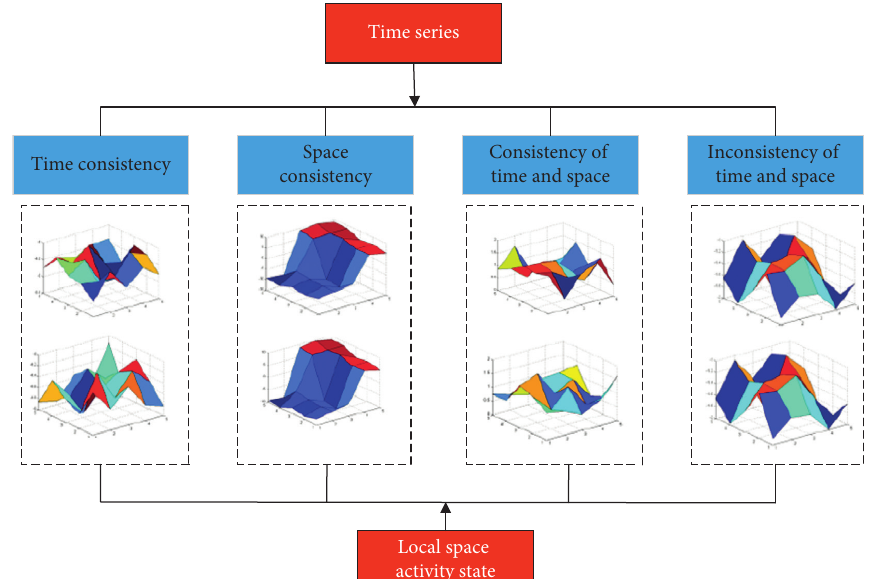
Figure 2: Design of fMRI simulation experiment based on FOCA